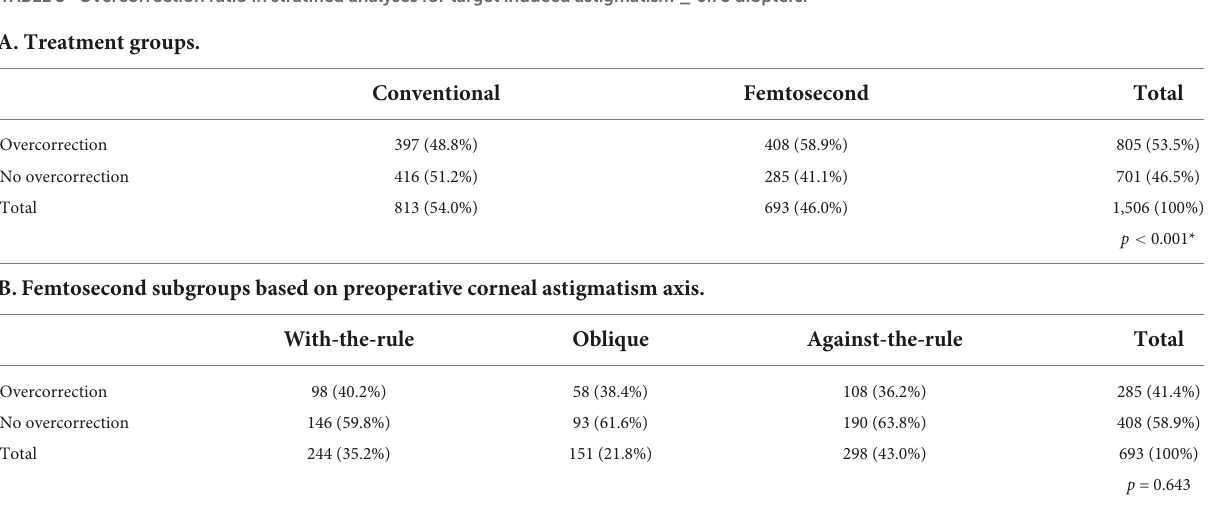
TABLE 3 Overcorrection ratio in stratified analyses for target induced astigmatism ≤ 0.75